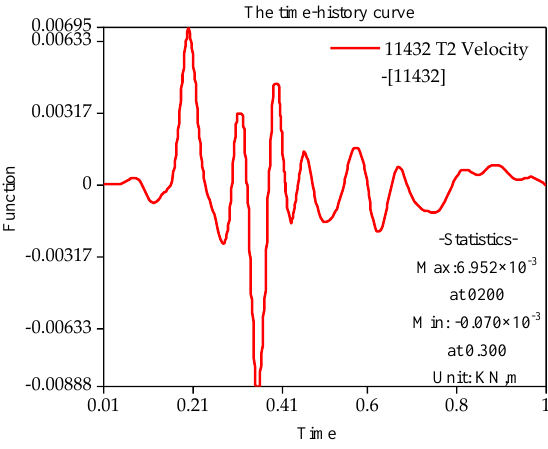
Figure 13. T2 Vibration curve on the basement of perilous rock.